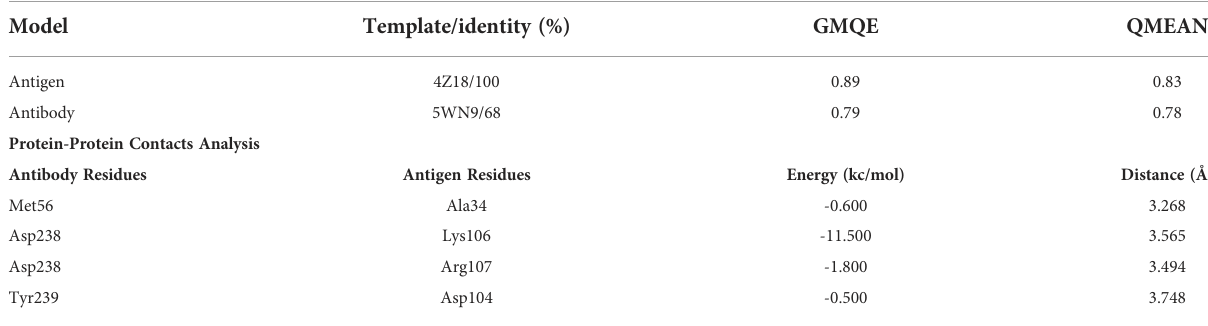
TABLE 2 The detail of homology modeling and protein contact analysis.